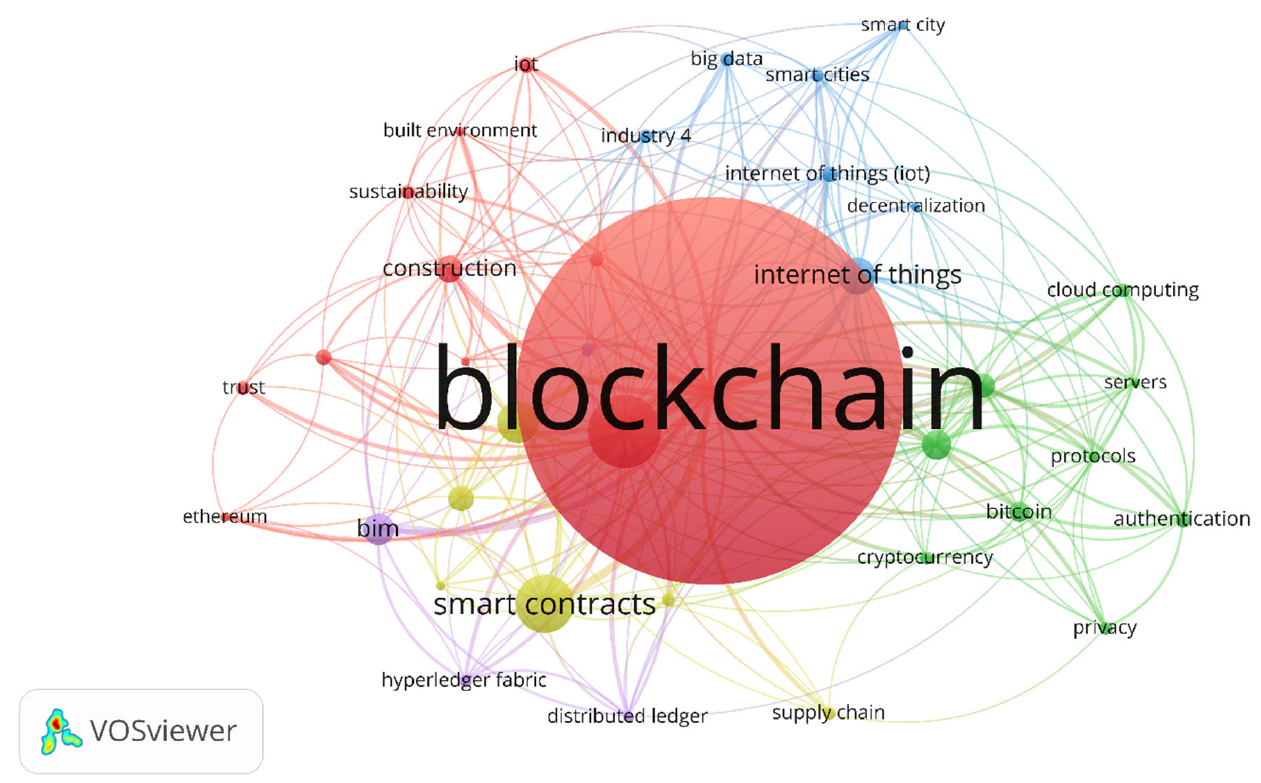
Figure 13. Network visualization of keywords co ‐ occurrence.